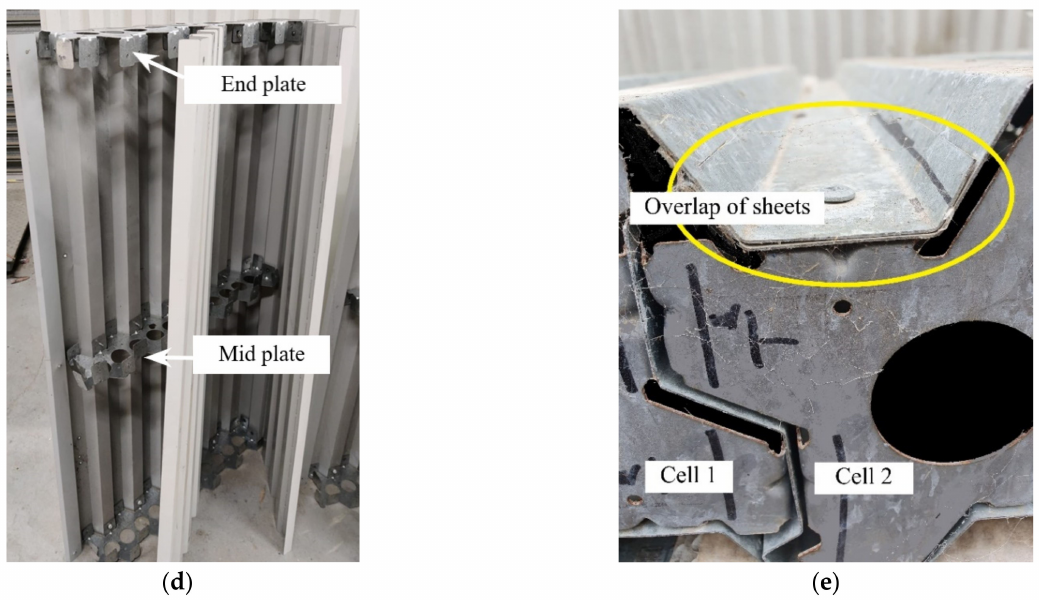
Figure 1. Prototype of hollow cellular panel. ( a ) Bent ‘L’ shaped corrugated sheet. ( b ) Slots for bending at open end. ( c ) Slots for bending at corrugation edges. ( d ) Open panel with mid plates ( e ) Overlap of sheets of a multi-cell panel.